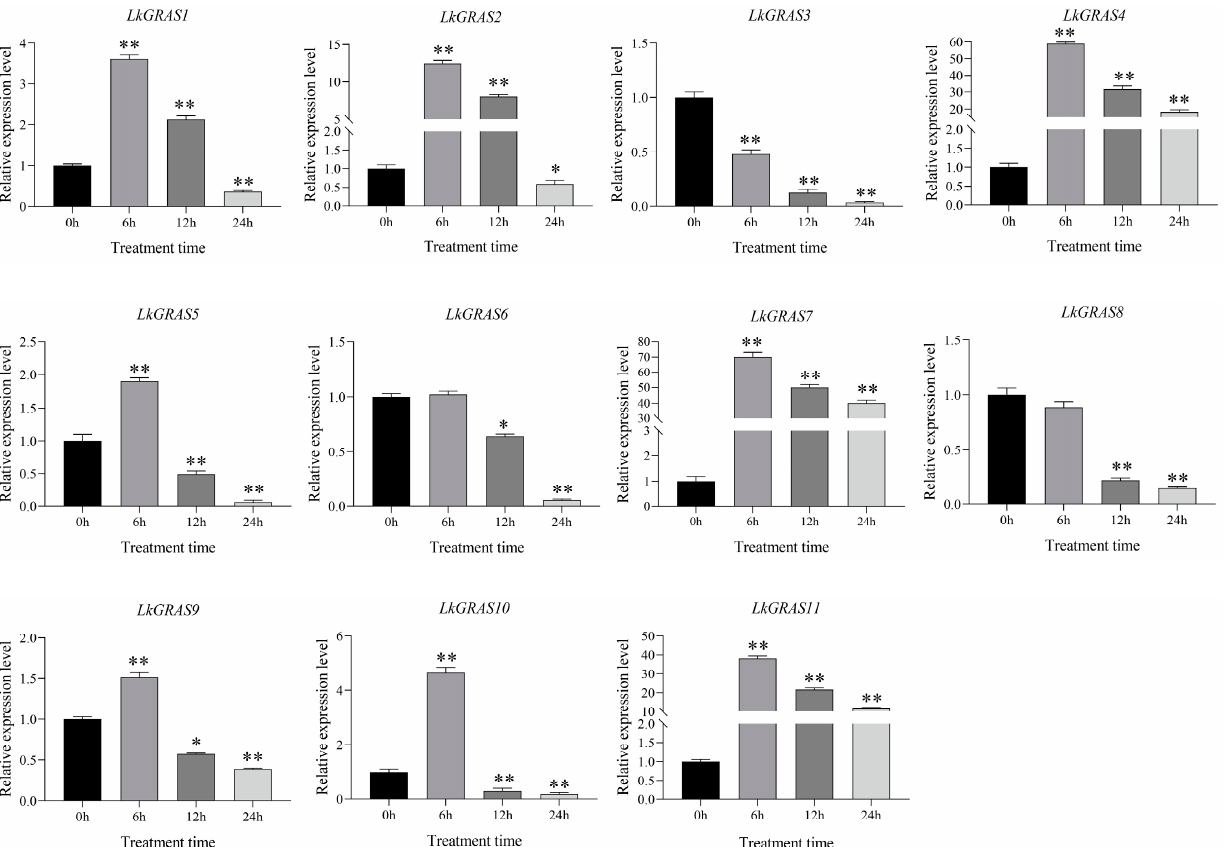
Figure 7. The relative expression levels of the LkGRAS genes in needles under ABA treatment using qRT-PCR. Error bars represent the deviations from three biological replicates. The x -axis represents the time points after 100 µ M ABA treatment (* p < 0.05, ** p <